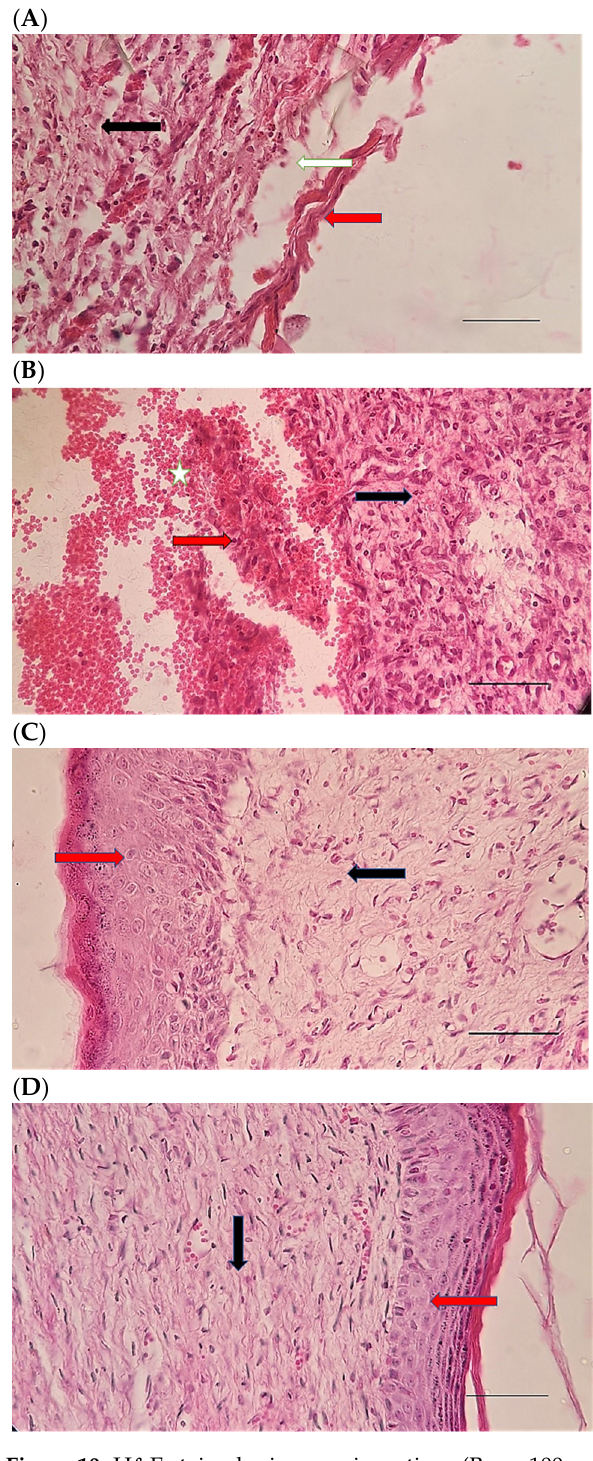
Figure 10. H&E stained microscopic sections (Bar = 100μm) wound in rats on day 21 of the study. ( A ) Control group; Formation of incoherent collagen fibers (black arrow), incomplete re-epithelialization (red arrow), edema (white arrow). ( B ) Ch group; Fine collagen formation (black arrow), incomplete epithelial tissue formation (red arrow), hemorrhage (white star). ( C ) ChSeN group; Fine collagen formation (black arrow), relatively thick epithelium formation (red arrow). ( D ) ChSeND group; Regular epithelial tissue formation (red arrow), relatively thick collagen fibers (black arrow).